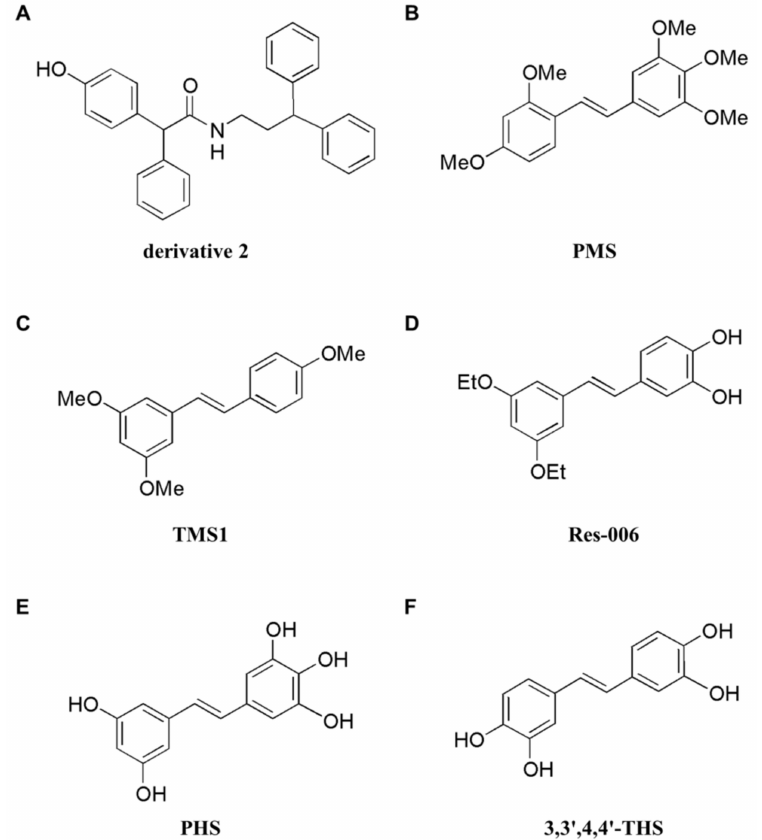
Figure 3. Structures of synthetic resveratrol derivatives. ( A ) derivative 2. ( B ) PMS, 2,3 (cid:48) ,4,4 (cid:48) ,5 (cid:48) -pentamethoxy- trans -stilbene. ( C ) TMS1, trans -3,5,4 (cid:48) -trimethoxystilbene. ( D ) Res-006, 3,5-diethoxy -3 (cid:48) ,4 (cid:48) -dihydroxy- trans -stilbene. ( E ) PHS, 3,3 (cid:48) ,4,5,5 (cid:48) -pentahydroxy- trans -stilbene. ( F ) 3,3 (cid:48) ,4,4 (cid:48) -THS, 3,3 (cid:48) ,4,4 (cid:48) -tetrahydroxy- trans